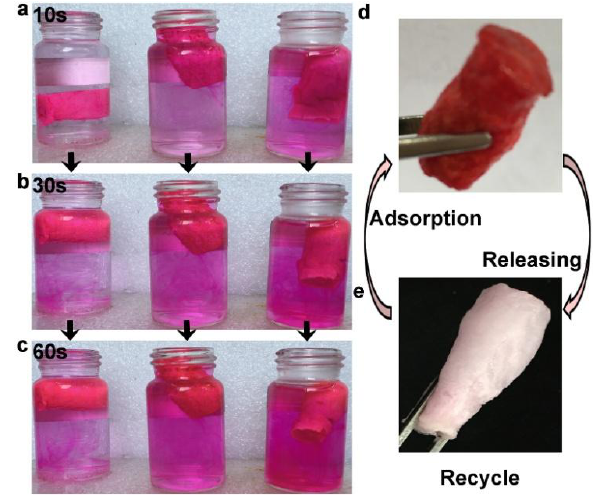
Figure 4. Photographs of dye release test, all samples were put in hot water for ( a ) 10 s, ( b ) 30 s and ( c ) 60 s. The bottles from left to right are pure PNIPAM and PNIPAM/BNNS-NH 2 prepared from BNNS-NH 2 concentration of 0.02 mg/mL and 0.04 mg/mL, respectively. Photographs of the